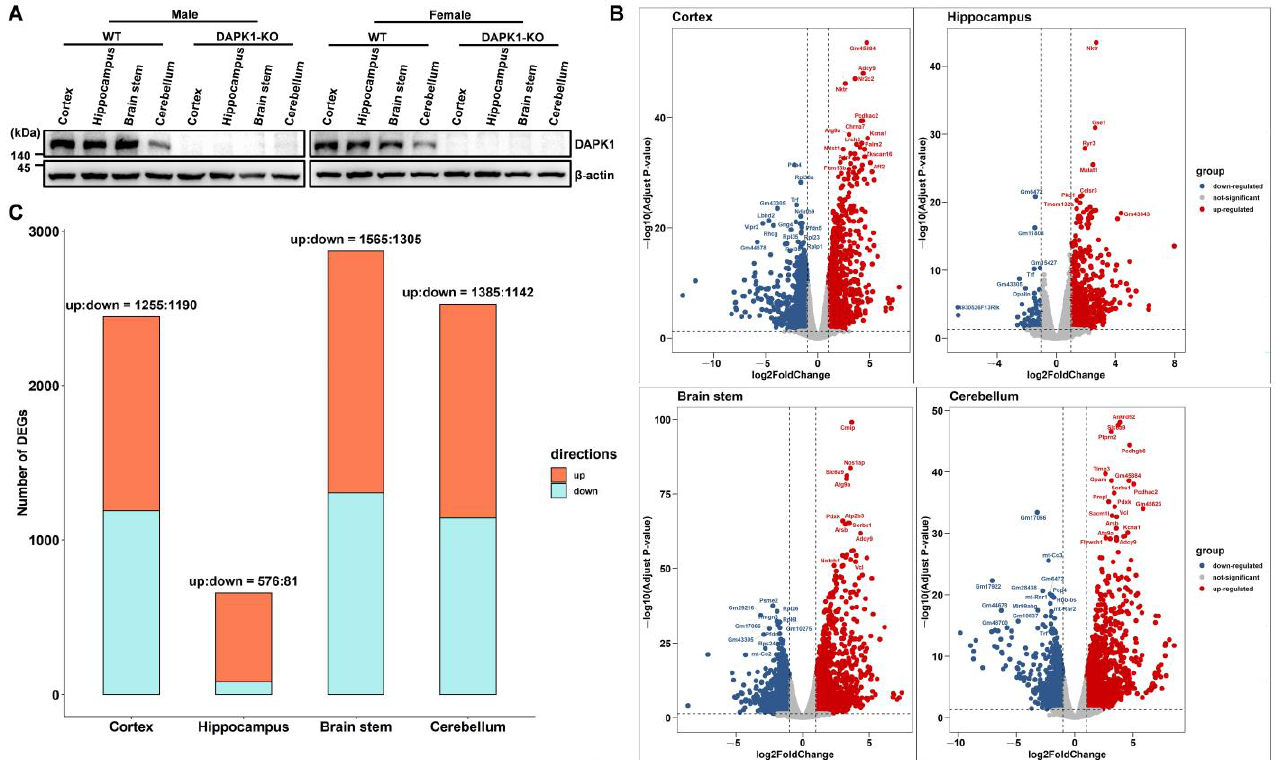
Figure 1. Transcriptional profiling of tissues from different brain regions in DAPK1-KO mice. ( A ) DAPK1 protein levels in tissues from four different brain regions of WT and DAPK1-KO male and female mice by immunoblotting analysis. ( B ) Differential gene expression volcano plots of tissues from each brain region of male mice by the edgeR method. The horizontal dotted line refers to the threshold of statistical significance with log, while the vertical dotted line refers to the threshold of the differential expressed ratio. ( C ) Number of DEGs in tissues of four brain regions for male